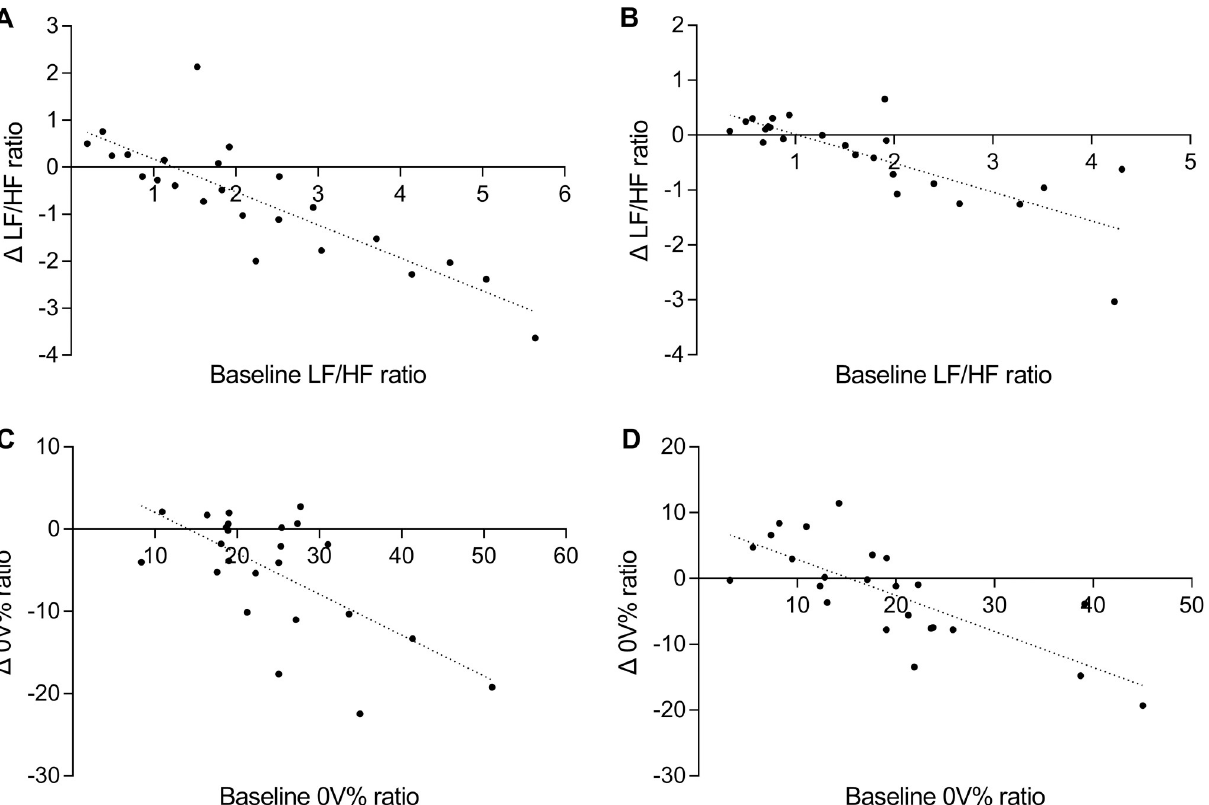
Fig 1. Baseline LF/HF ratio and 0V% significantly predicted changes in LF/HF and 0V% during taVNS. A higher baseline LF/HF ratio was associated with a greater LF/HF decline (morning: R 2 = 0.703, p < 0.0001, A; evening: R 2 = 0.6161, p < 0.0001, B), whereas a higher baseline 0V% was associated with a greater 0V% decline (morning: R 2 = 0.4147, p = 0.0007, C; evening: R 2 = 0.5751 p < 0.0001,